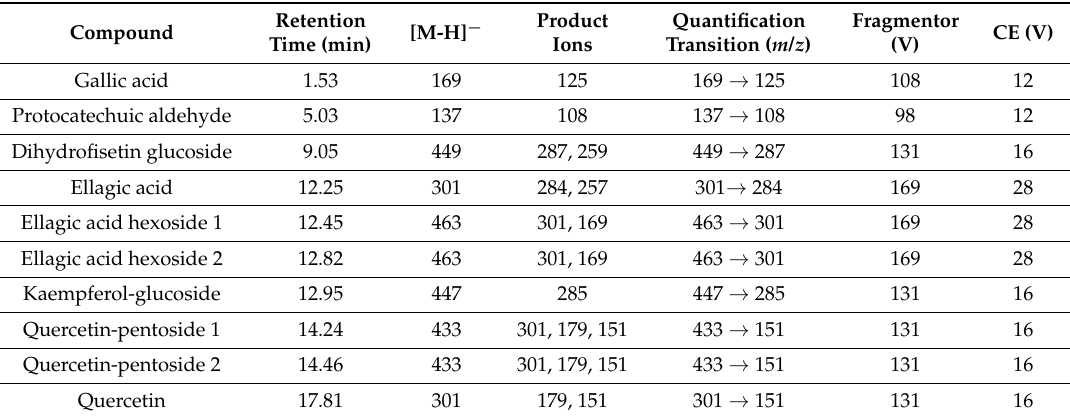
Table 3. Analytical parameters of HPLC-ESI-MS/MS